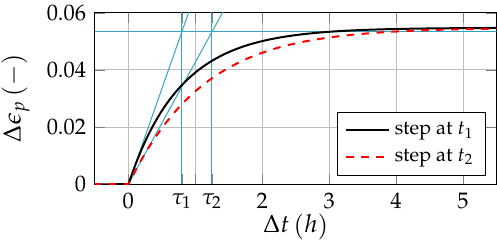
Figure 10. Normalized particle porosity ∆ (cid:101) p surrounding the set point switches of ˙ m inj at t 1 and t 2 according to the second simulation